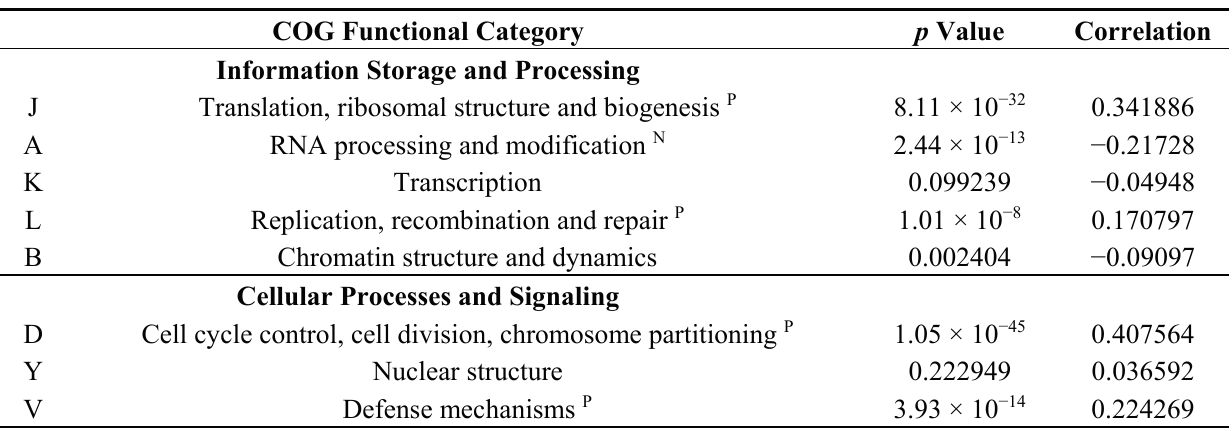
Table 3. The correlation of each Clusters of Orthologous Groups (COG) functional subcategory and strand composition